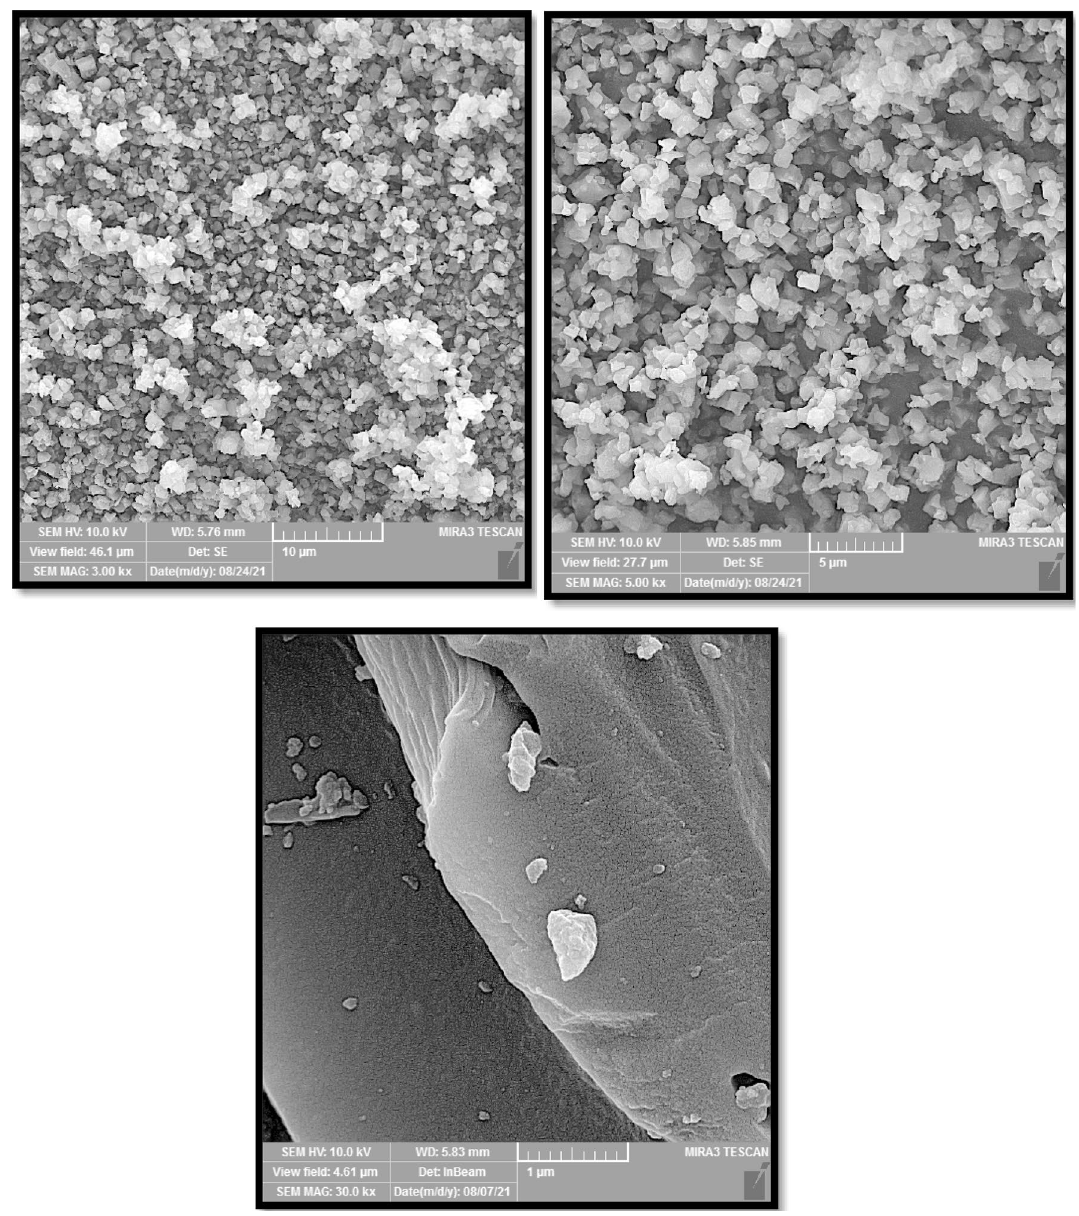
Figure 1. The FESEM images of (left) MOF-5 crystals with two magnification, and (right) ACS-RGO Nano